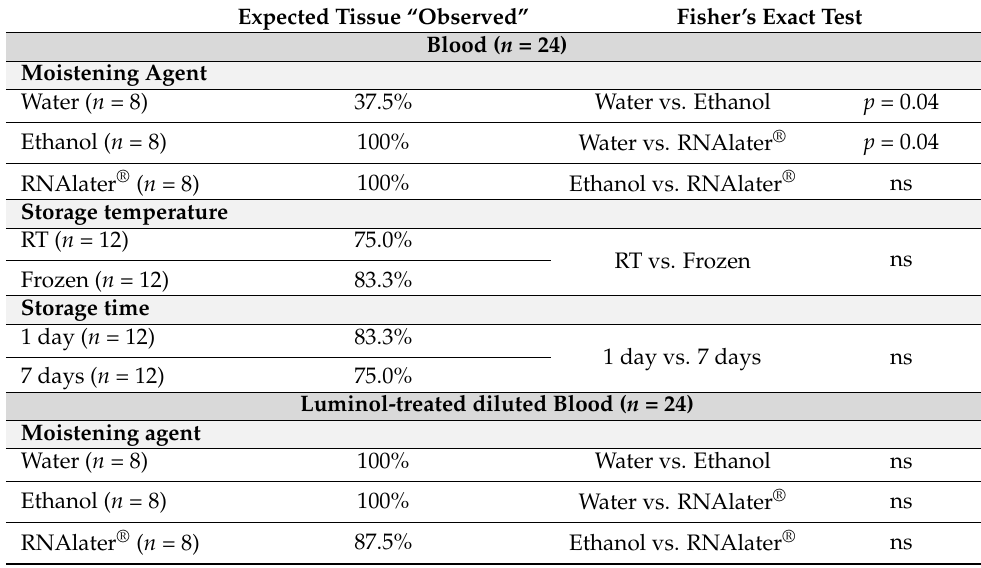
Table 3. Percentages of the experimental samples in which the expected tissue was “observed,” according to the adopted scoring method for mRNA profiling, subdivided by stain type, moistening agent, storage temperature, and storage time before processing. p -values of Fisher’s test adjusted for multiple testing are shown in the column to the right (ns denotes